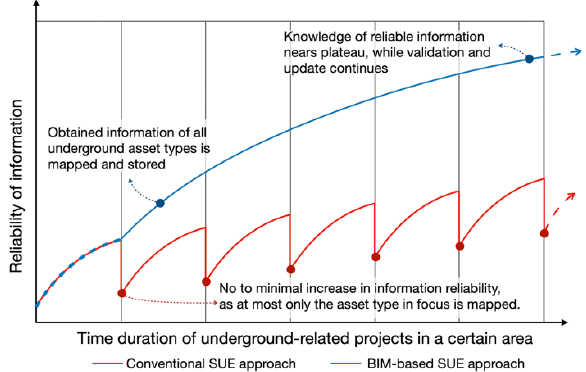
Figure 1. Loss of subsurface utility information quality caused by SUE results not being mapped and stored.